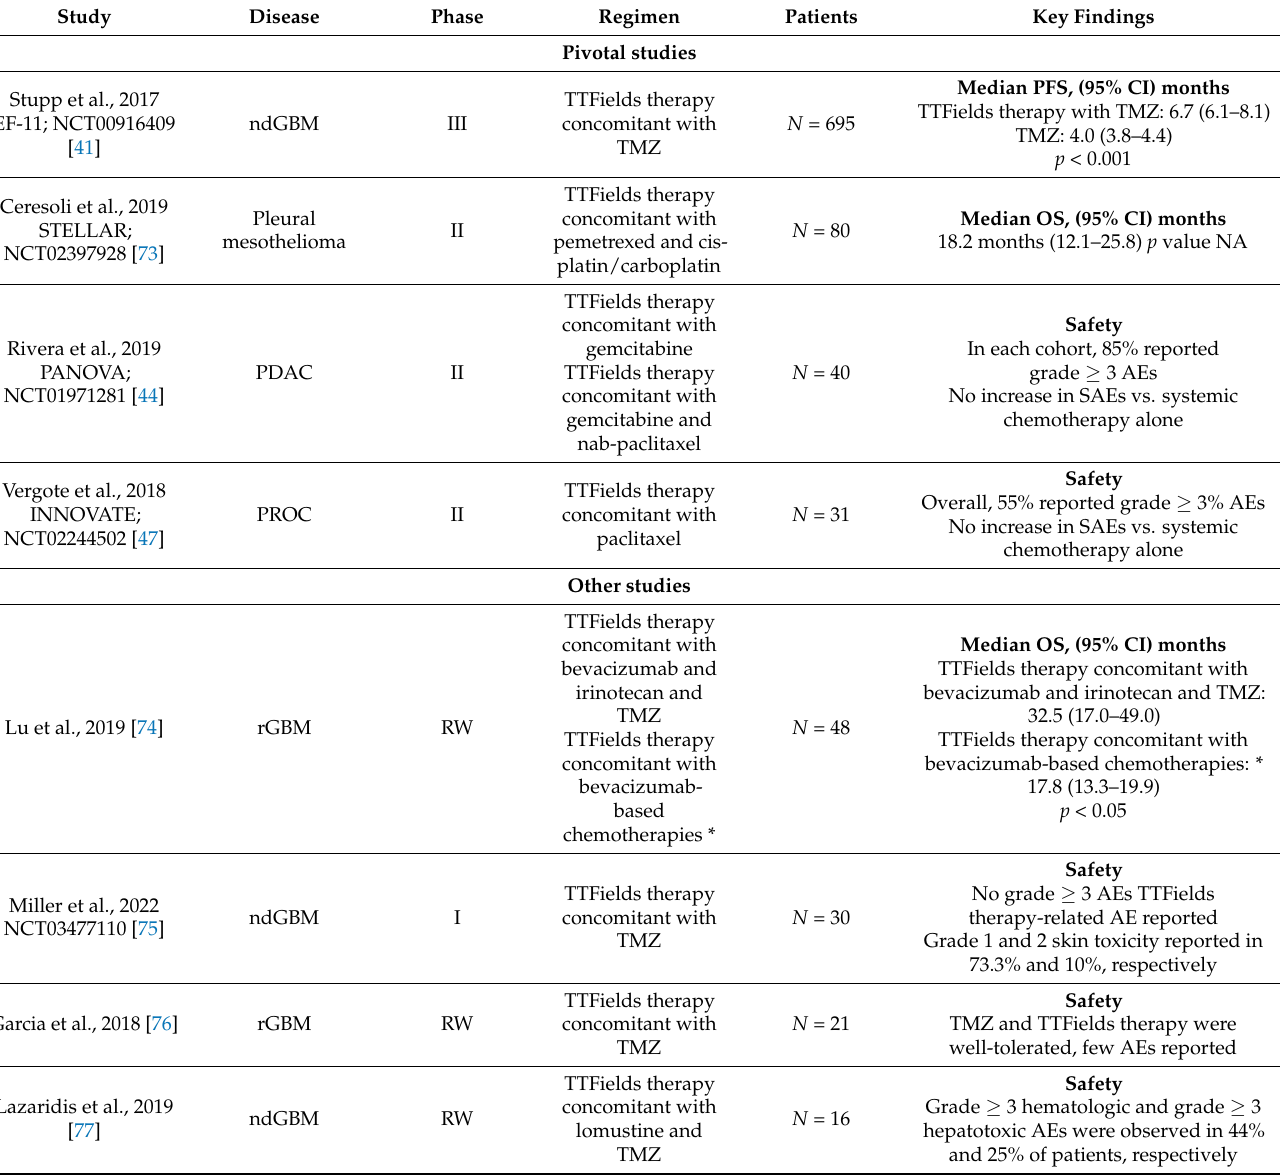
Table 3. A summary of clinical studies investigating TTFields therapy concomitant with